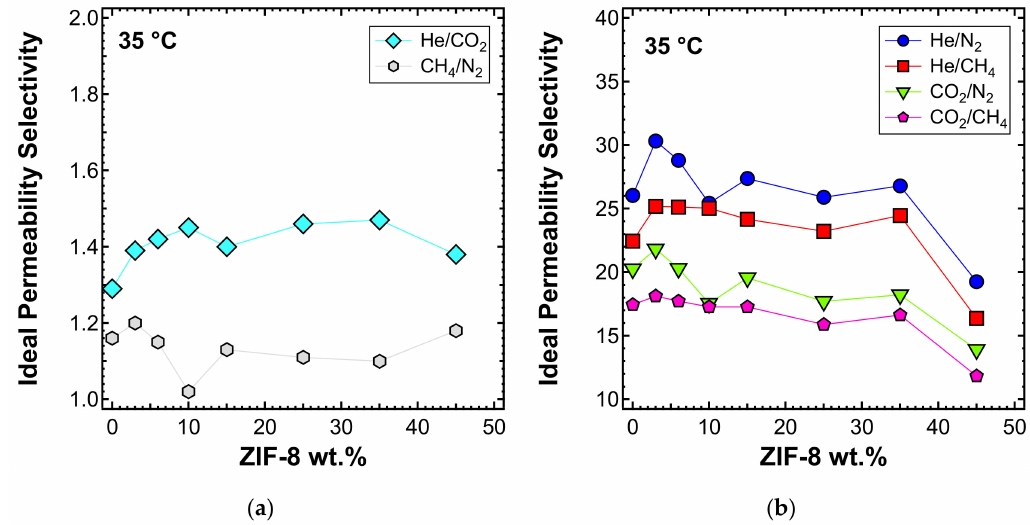
Figure 10. Ideal selectivity for ( a ) He / CO 2 and ( b ) other gas couples at 35 ◦ C with an upstream pressure of 1.3 bar in ZIF-8 / PPO MMMs.